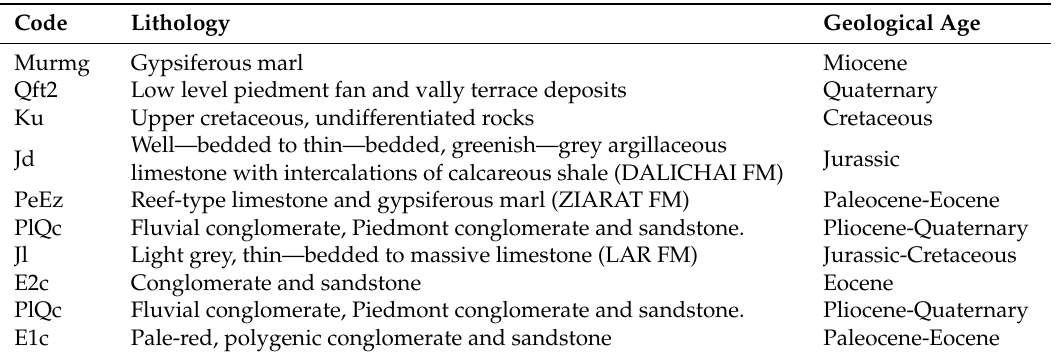
Table 1. Lithology of the study area.